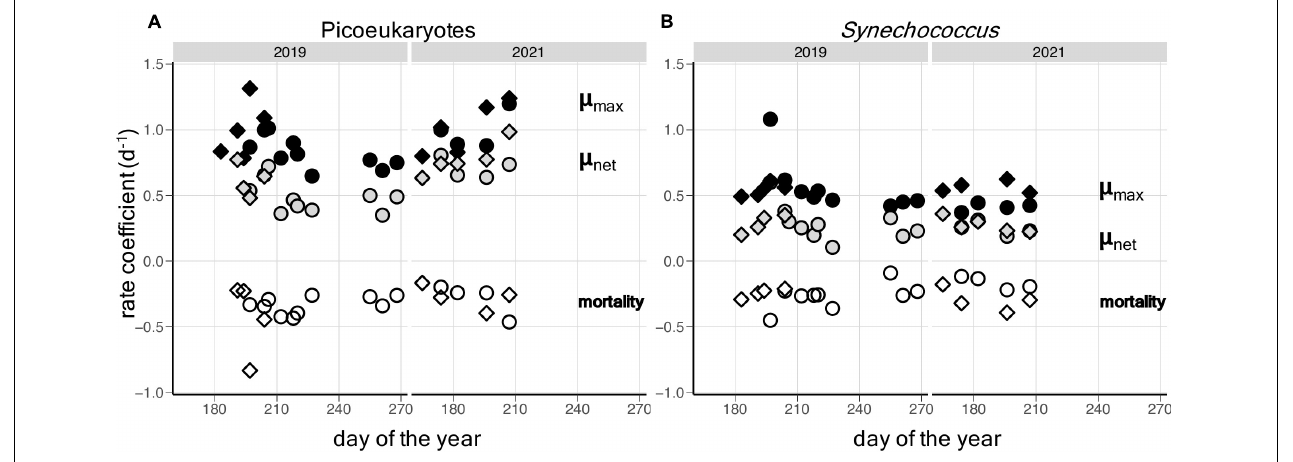
FIGURE 3 | Temporal patterns of net ( µ net ) and gross growth ( µ max ) rates and mortality due to grazing ( m ) in: (A) picoeukaryote; and (B) Synechococcus populations in Gulf of Maine coastal waters during the summers of 2019 and 2021. Values derived from saturation experiments are shown as circles and values from dilution experiments are shown as